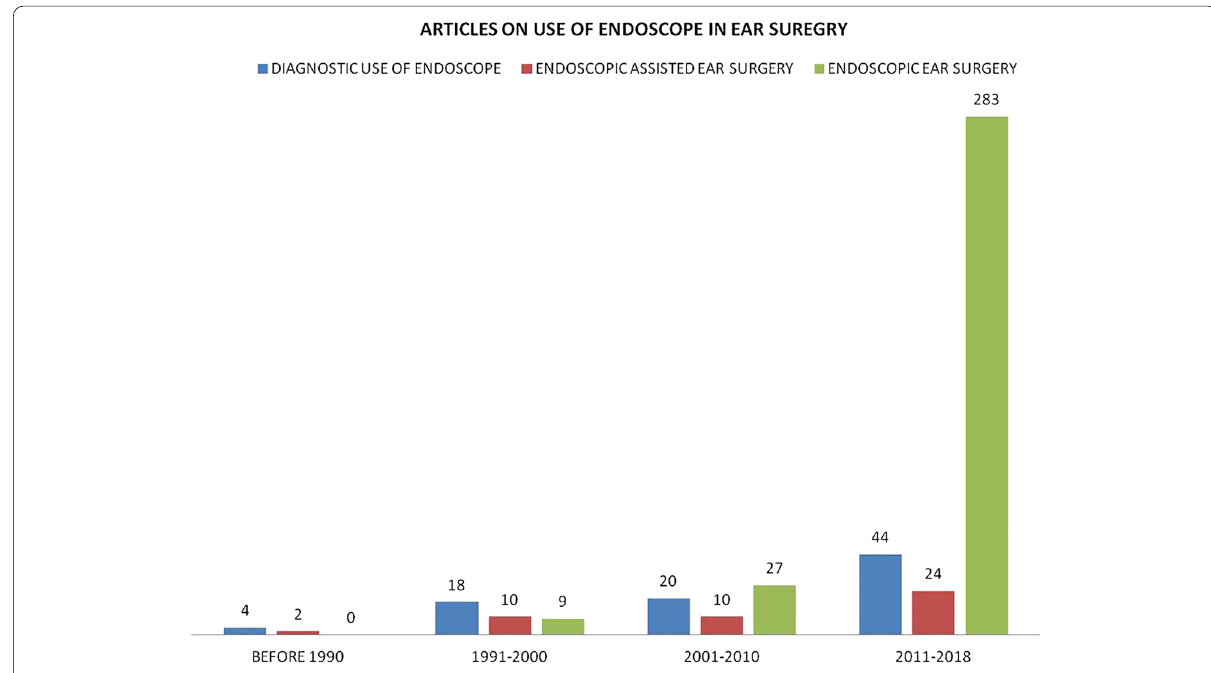
Fig. 1 Number of publications categorized by the pattern of utilization of the endoscope in ear surgery per the last four decades [15]